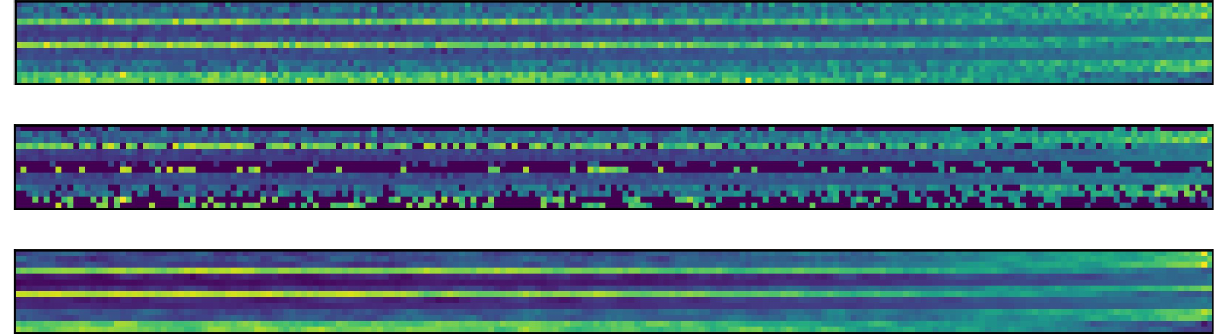
Figure 4. The visualization of complete data, corrupted data, and imputation data of engine 76 in FD001 testing set under 0.3 missing rate.